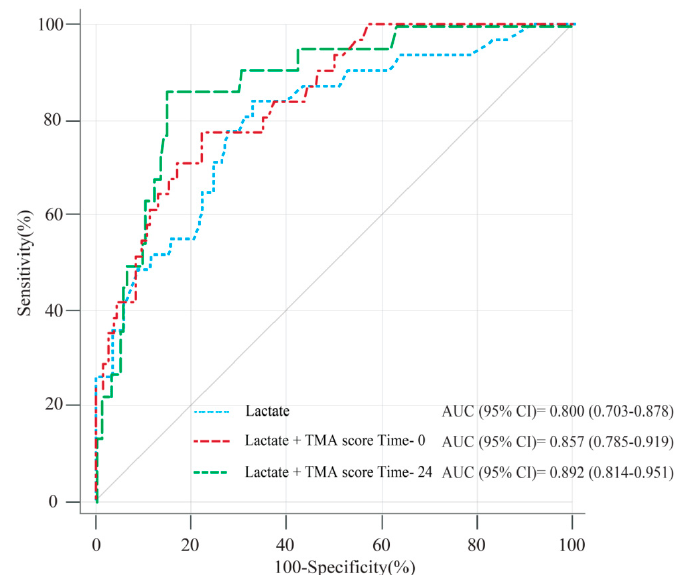
Figure 5. Receiver-operating characteristic curve of lactate and the thrombotic microangiopathy (TMA) score for the 30-day mortality of patients with septic shock. Table 3. Sensitivity, specificity, positive predictive value, and negative predictive value of the TMA score, lactate, and a combination of lactate with the TMA score for predicting the 30-day mortality of patients with septic shock.